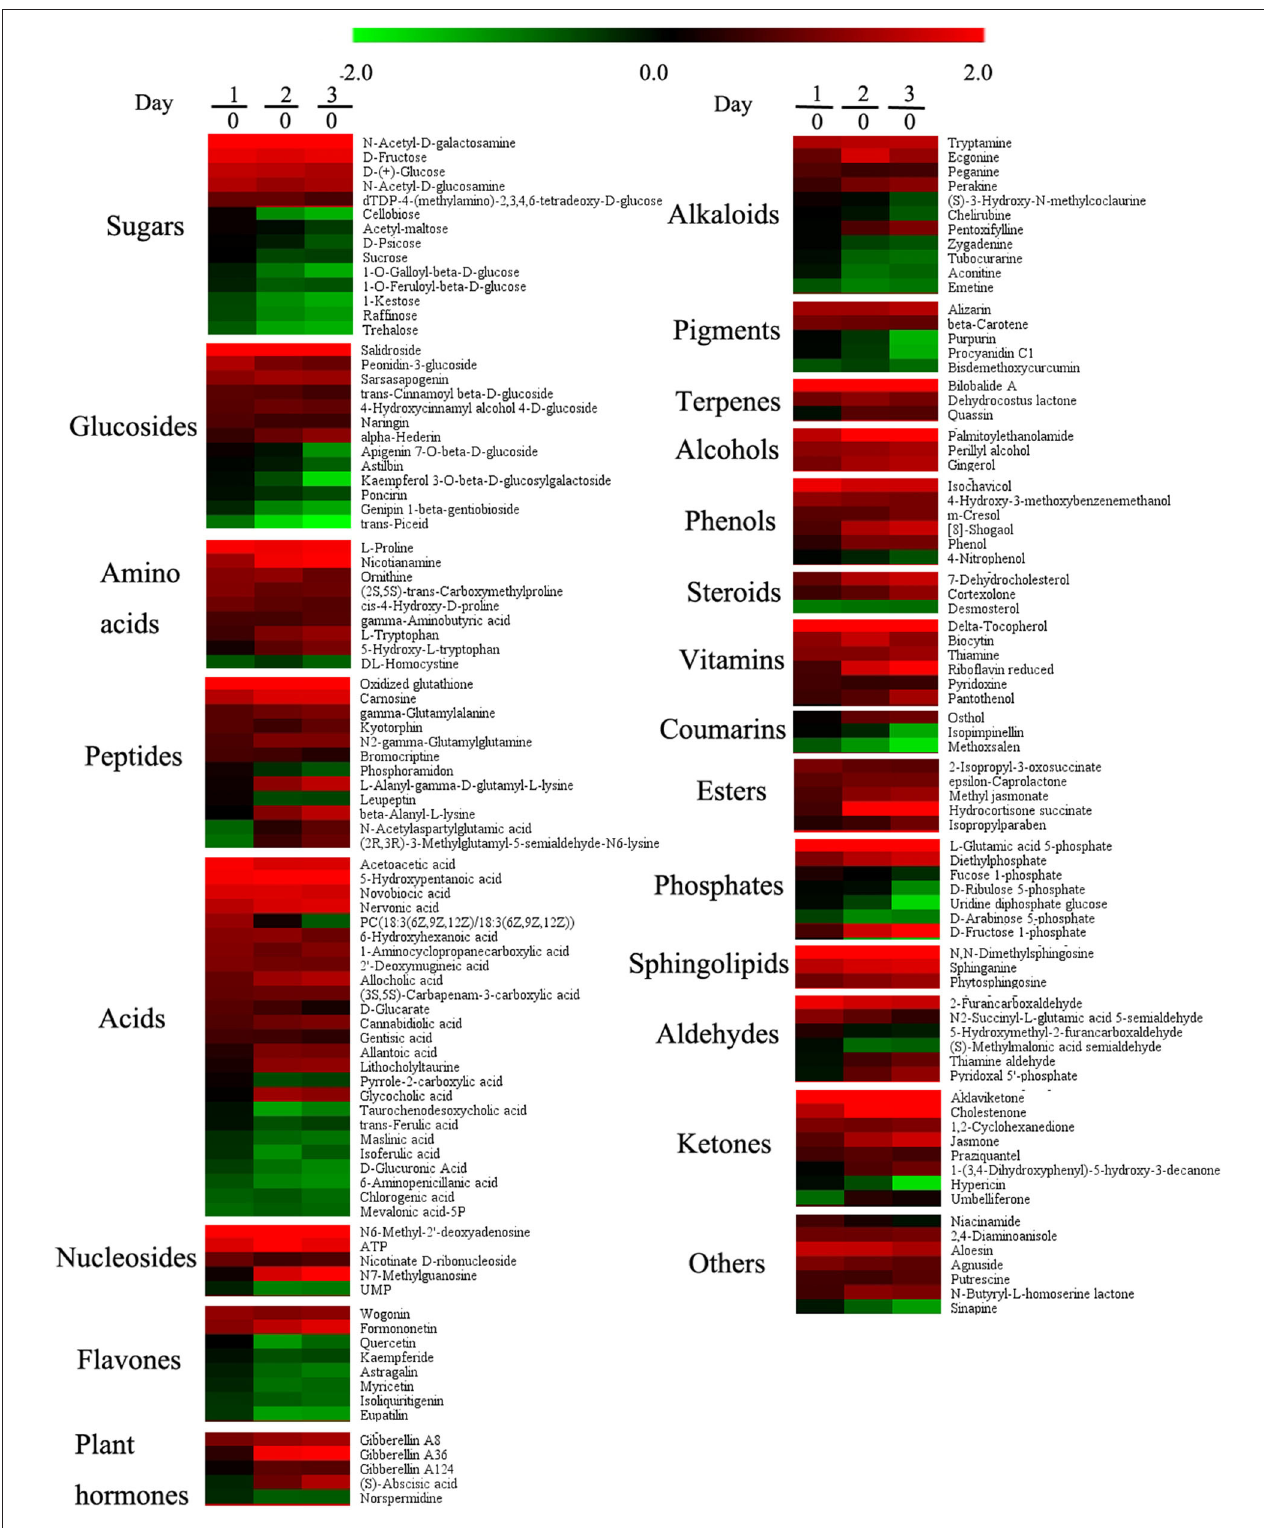
FIGURE 3 | Effects of low temperature on metabolites of pollen in pitaya. Each data point represents a mean ( n = 5). Samples on days 0, 1, 2, and 3 were used for the experiment and 167 metabolites met the conditions (VIP > 1 and p < 0.05) as differentially expressed metabolites.